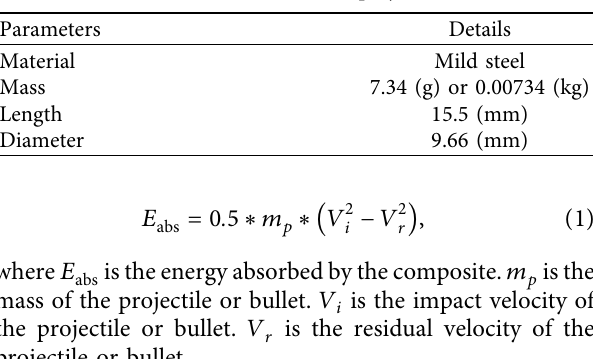
Figure 5: Hand layup process: (a) mixing of hardener and alumina powder and (b) fabricated composite laminates. Table 2: Details of the